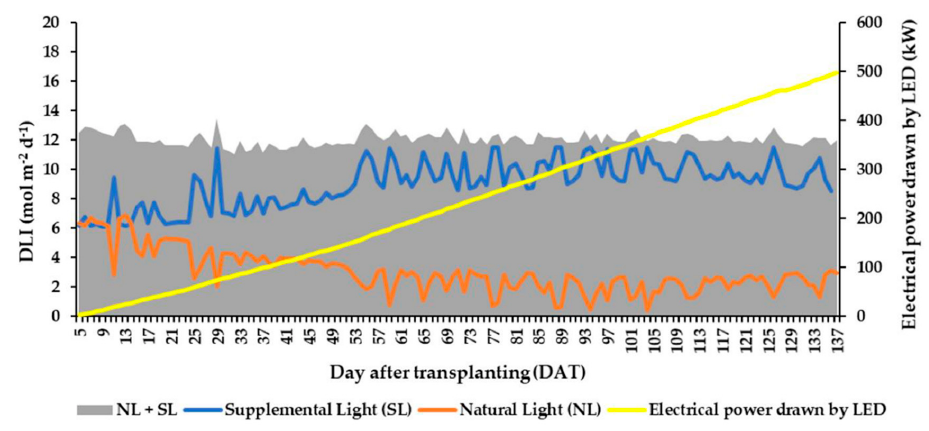
Figure 3. Daily light integral (DLI) from sunlight (Natural Light, NL), LED interlighting (Supplementary Light, SL), total DLI from sunlight and LED (NL + SL), and electrical power drawn by LED interlighting during cultivation (from September to